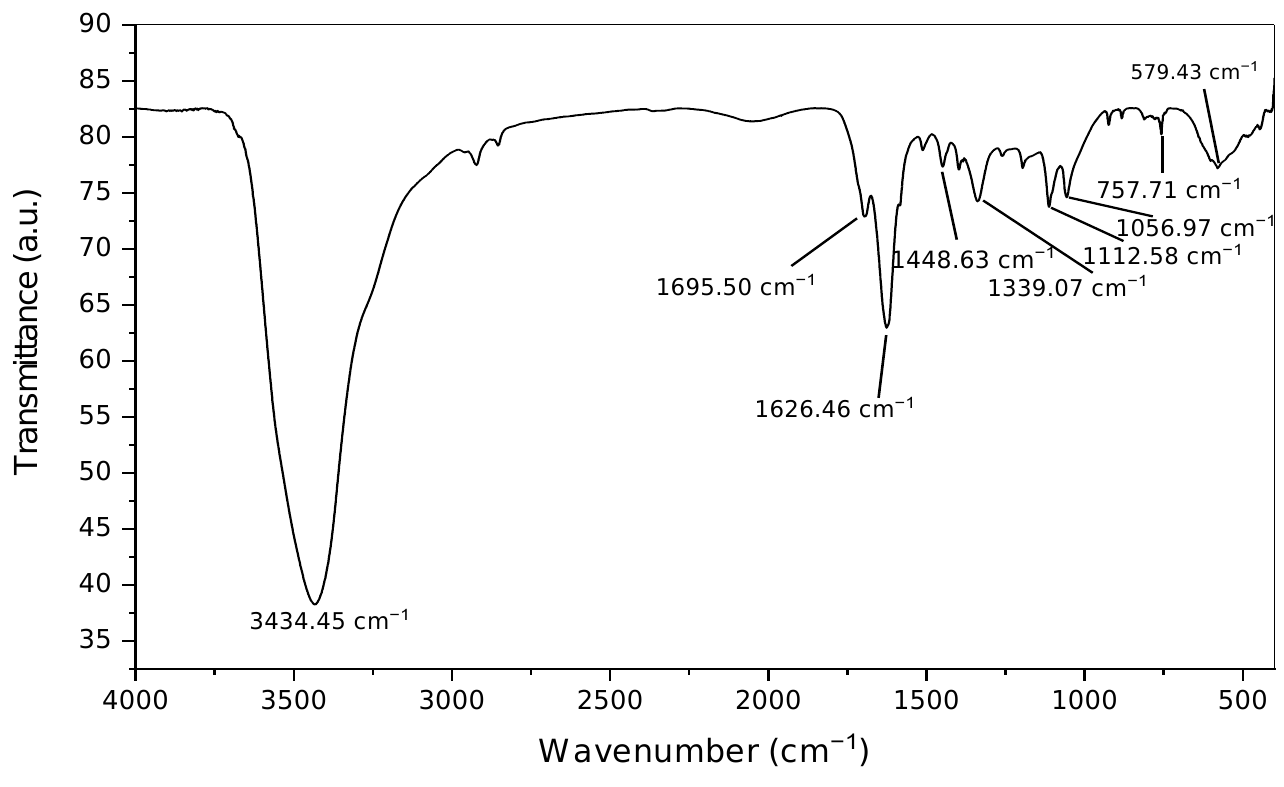
Figure 4. Particle size distribution histogram of AgNPs synthesized utilizing Punica granatum aque- ous peel extract.